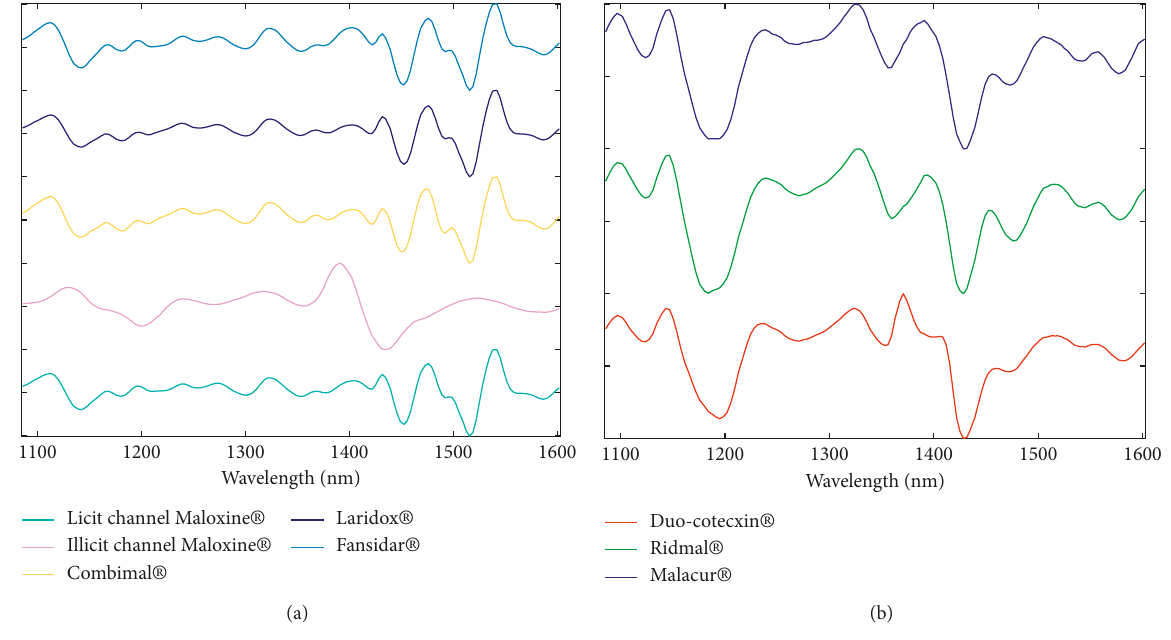
Figure 1: Preprocessed mean spectra in the 1085–1601 nm range. (a) SP samples. (b) DP samples.